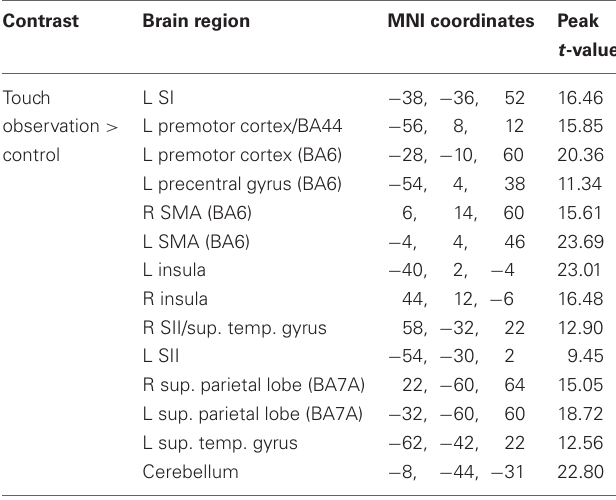
Table 1 | Results of random effects analysis (at p < 0 . 05, FWE corrected; L, left hemisphere; R, right hemisphere; masked with real touch > baseline) for contrast touch observation relative to